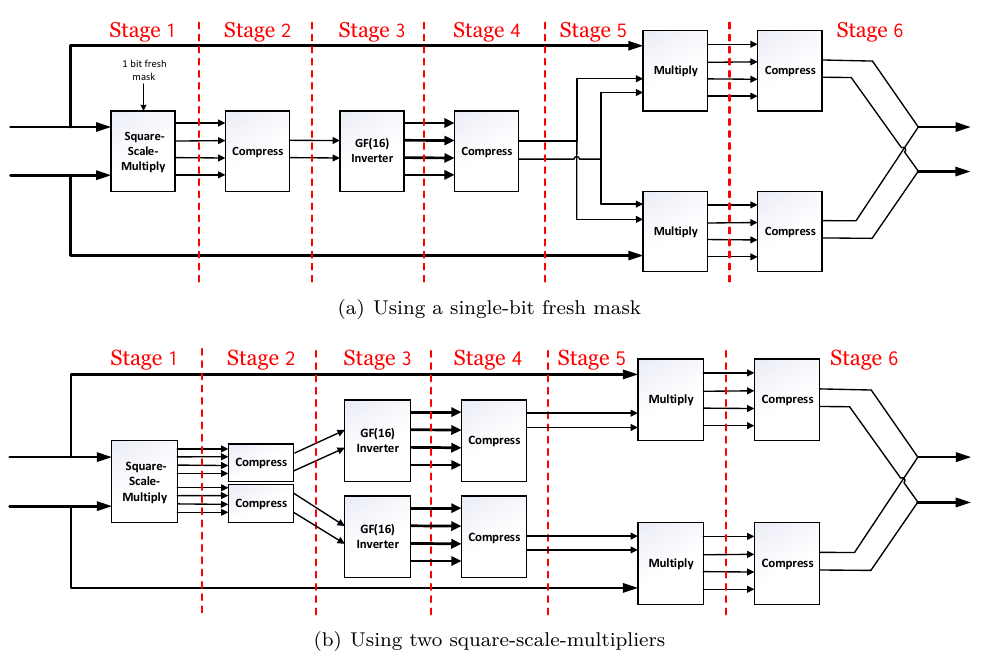
Figure 5: Our constructions for the shared inversion in GF (2 4 ) 2 by 2 shares.